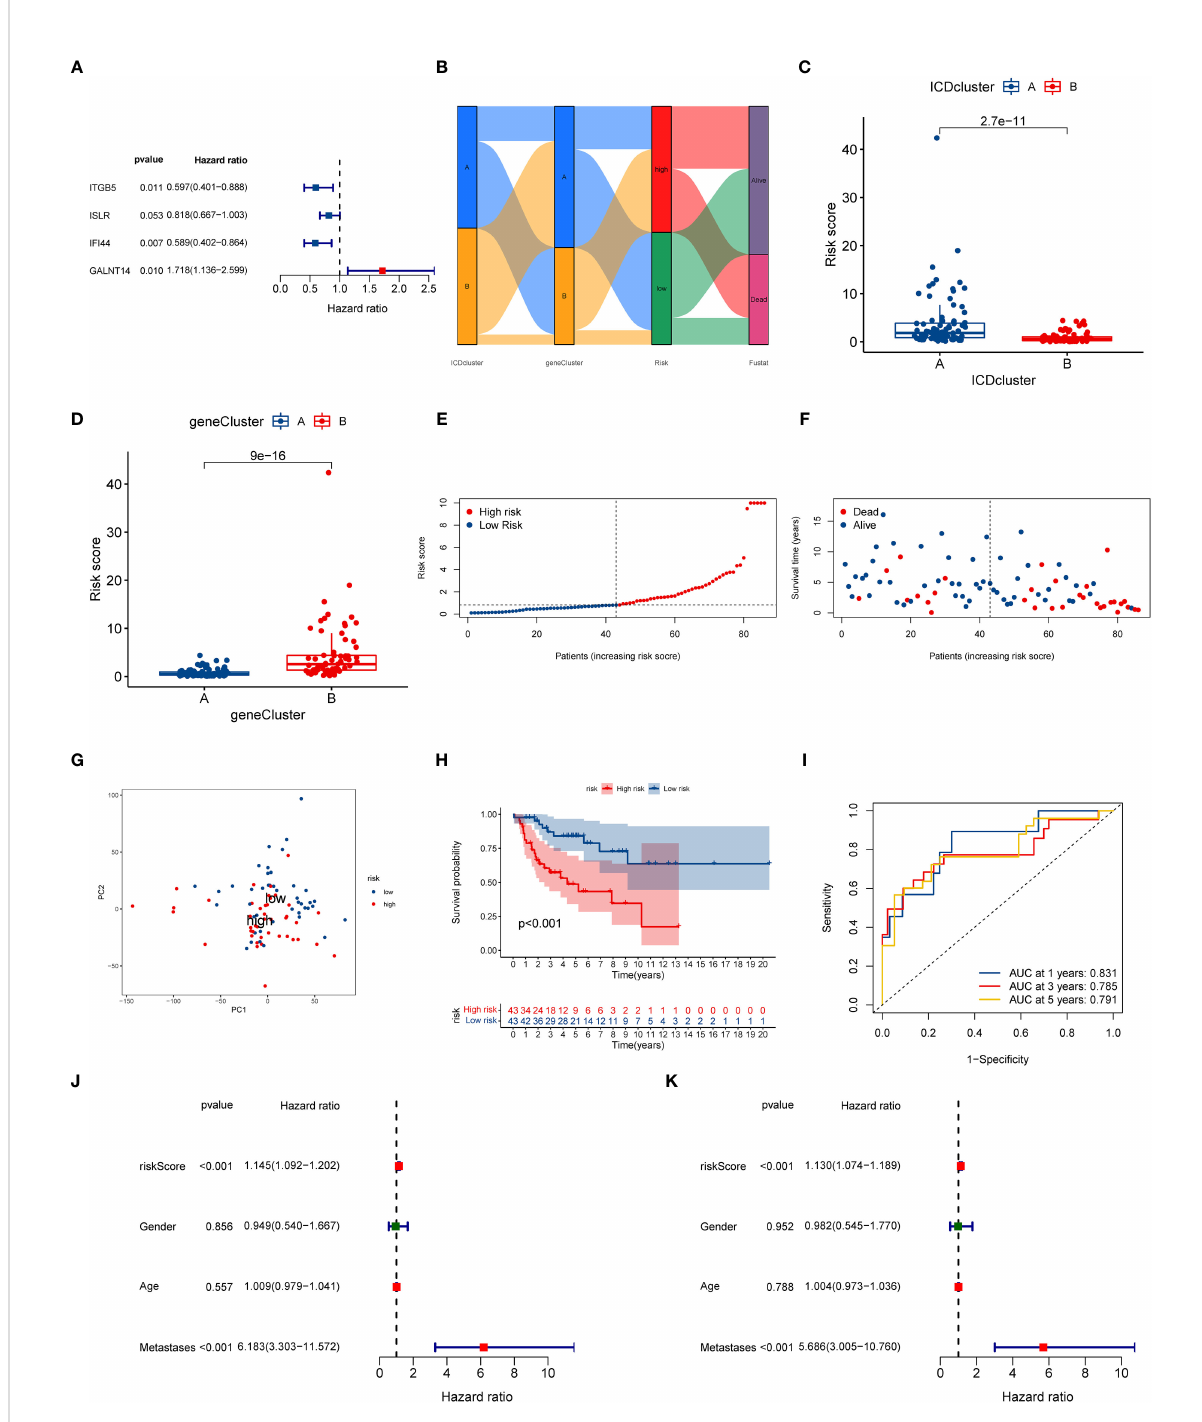
FIGURE 5 Construction of ICD-related signature in the training cohort. (A) Multivariate Cox regression analyses of the model gene. (B) Sankey plot of ICD- related subtype distribution in groups with different ICD risk scores and survival status. (C) The discrepancy in ICD risk score between the two ICD-related subtypes. (D) The discrepancy in ICD risk score between the two gene cluster. (E) The risk curve of each OS patient is reordered by risk score. (F) The scatter plot showed the overall survival status of each OS patient. (G) The PCA analysis is based on the ICD score in the training cohort. (H) K-M survival curve of overall survival by distinct ICD risk score groups for patients in the training cohort. (I) The ROC curves for predicting 1-, 3-, and 5-year OS survival according to ICD-related signature in the training cohort. (J) Univariate COX analysis result based on ICD risk score and clinical characteristics. (K) Multivariate COX analysis result based on ICD risk score and clinical characteristics. ICD, Immunogenic cell death; PCA, Principal component analysis; ROC, Receiver operating characteristic; OS, Osteosarcoma; K-M,